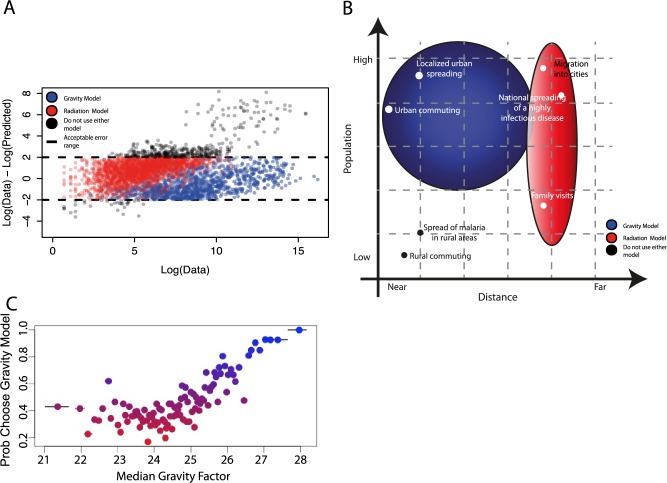
The utility of each model to describe travel in various settings.A) For travel between all pairs of locations, we compared the error in the actual versus predicted amount of travel. If this error was not within defined bounds (outside of the dotted black lines) (see Materials and Methods), we determined that both models do not adequately describe this travel (shown in black). For the remaining volumes and routes of travel, we determined if the gravity model (blue) or the radiation model (red) performed better to identify which model should be used in various settings. For example, the radiation model does much better than the gravity model predicting low volumes of travel and vice versa (shown in red versus blue). B) A schematic highlighting the situations when a radiation model is preferred over a gravity model and when caution should be taken using the predicted results of either model. Scenarios to use a gravity model over a radiation model include: travel to and from a major population centre, over short distances, and when predicting large volumes of travel. A radiation model should be used over a gravity model when describing travel between rural areas and low volumes of travel. Caution should be taken using either model if the travel is between locations of intermediate rural population and over short distances. C) We performed a logistic regression to determine when to use each model for various amounts of travel (a gravity factor). As the amount of travel increases, the number of times the gravity model outperforms the radiation model increases. For examples for the lowest amounts of travel 43% of the time a radiation model if preferable to a gravity model. In contrast for the largest amount of travel, all of these routes (100%) were better predicted with a gravity model than a radiation model.